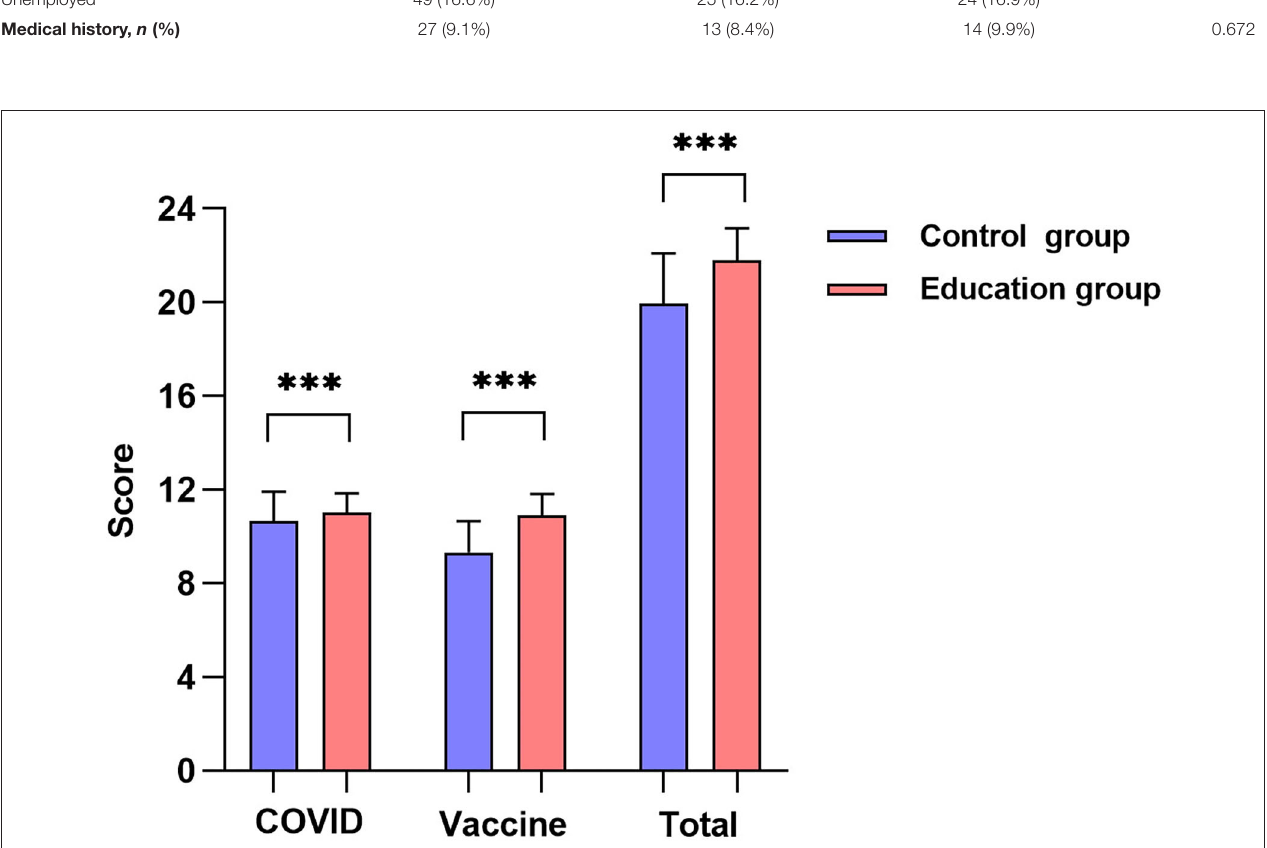
FIGURE 2 | Knowledge score of education group and control group (*** P <